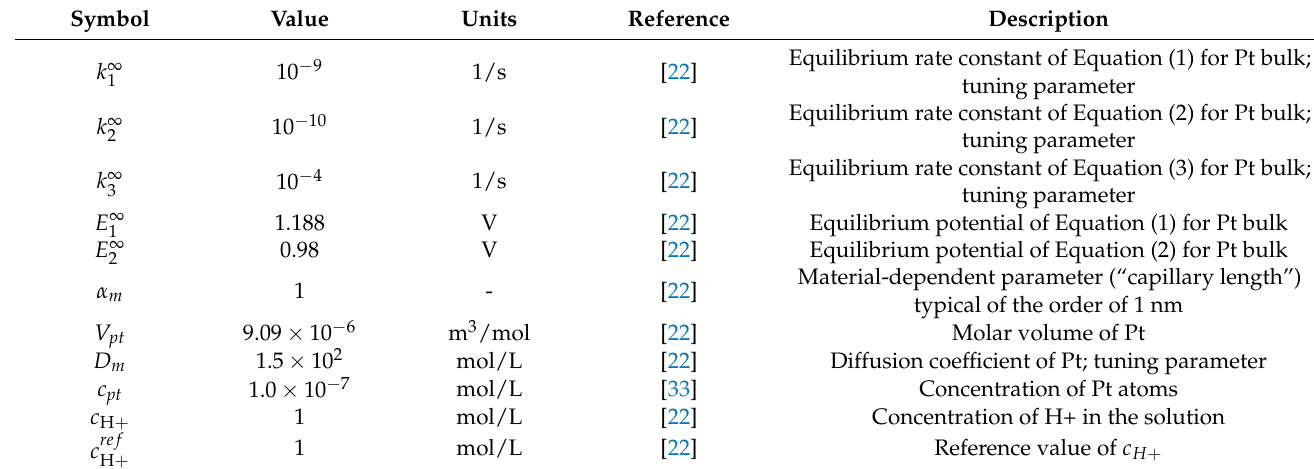
Table 1. The parameters used in the Pt degradation model.